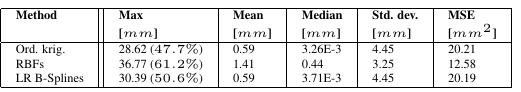
Table 2: Summary statistics for the error distribution of the accu- racy evaluation at different scales. Table 3: Statistics for the average number of extracted persistent maxima. Method τ = 0 . 05 τ = 0 . 15 τ = 0 . 25